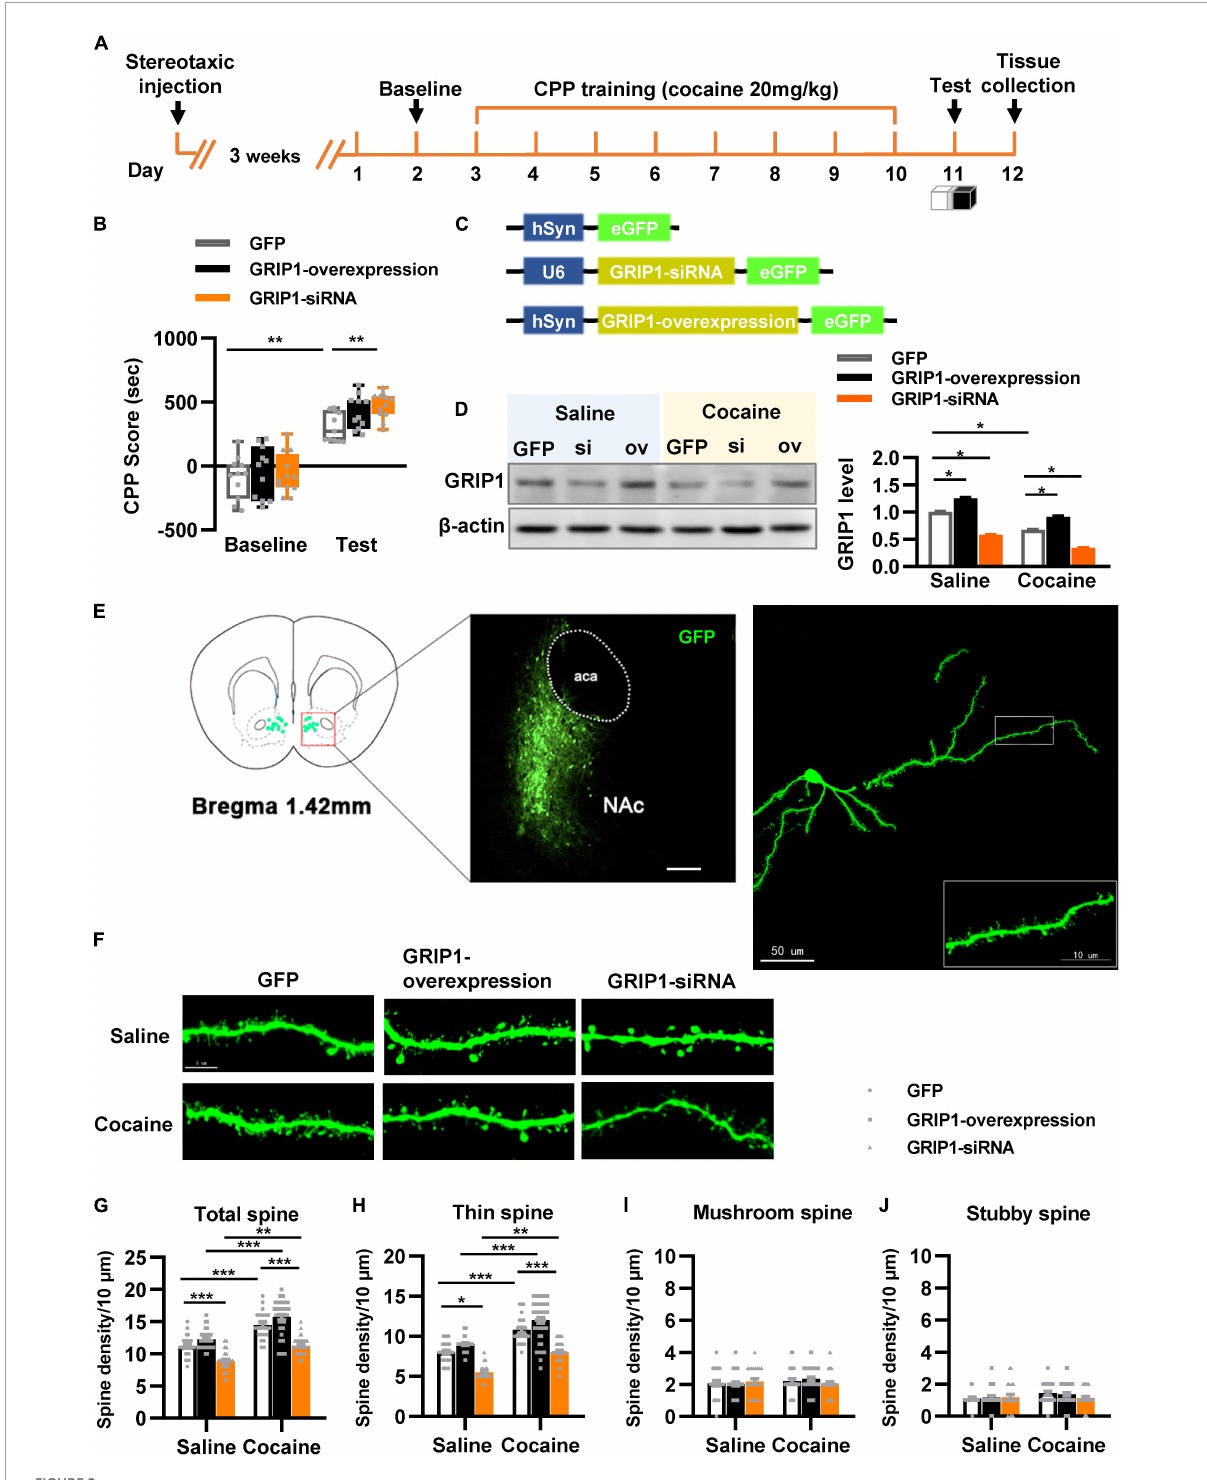
FIGURE2 GRIP1 interference enhances cocaine acquisition and decreases spine density. (A) Experimental design for the behavioral tests and spine analysis. Three-compartment biased CPP models were used. (B) GRIP1-siRNA increased cocaine-induced place preference and GRIP1 overexpression did not affect cocaine-induced place preference. (C) Viral vectors used to interfere with the expression of GRIP1. (D) The expression of GRIP1 in the NAc interfered with GRIP1-siRNA and GRIP1 overexpression at 0 min after cocaine acquisition. (E) Representative images of the injection site (left) and spine densities on terminal dendrites (right). (F) Representative images of GFP-labeled dendrites. (G–J) The statistical data for total spine, thin spine, mushroom spine, and stubby spine density. n = 20–30 dendrites obtained from 8–10 mice per group. * P < 0.05, ** P < 0.01, and *** P <